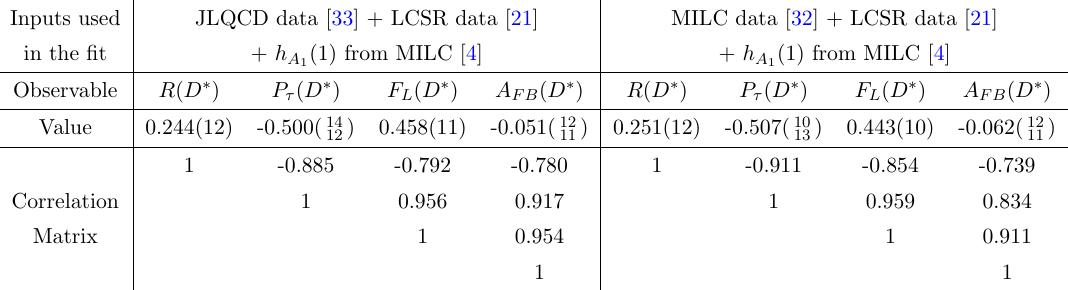
Table 12. Predictions for and the correlations between the observables in B ! D (cid:3) (cid:28)(cid:23) (cid:28) decays corresponding to the (cid:12)ts in table